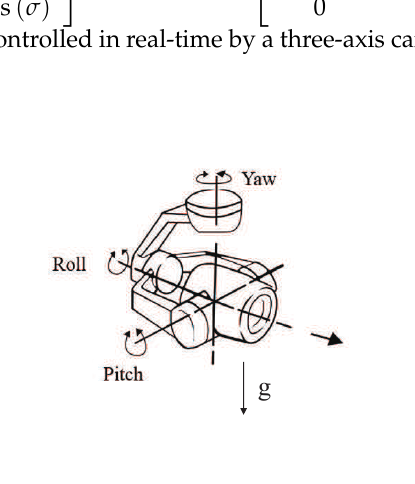
Figure 4. UAV PTZ-camera